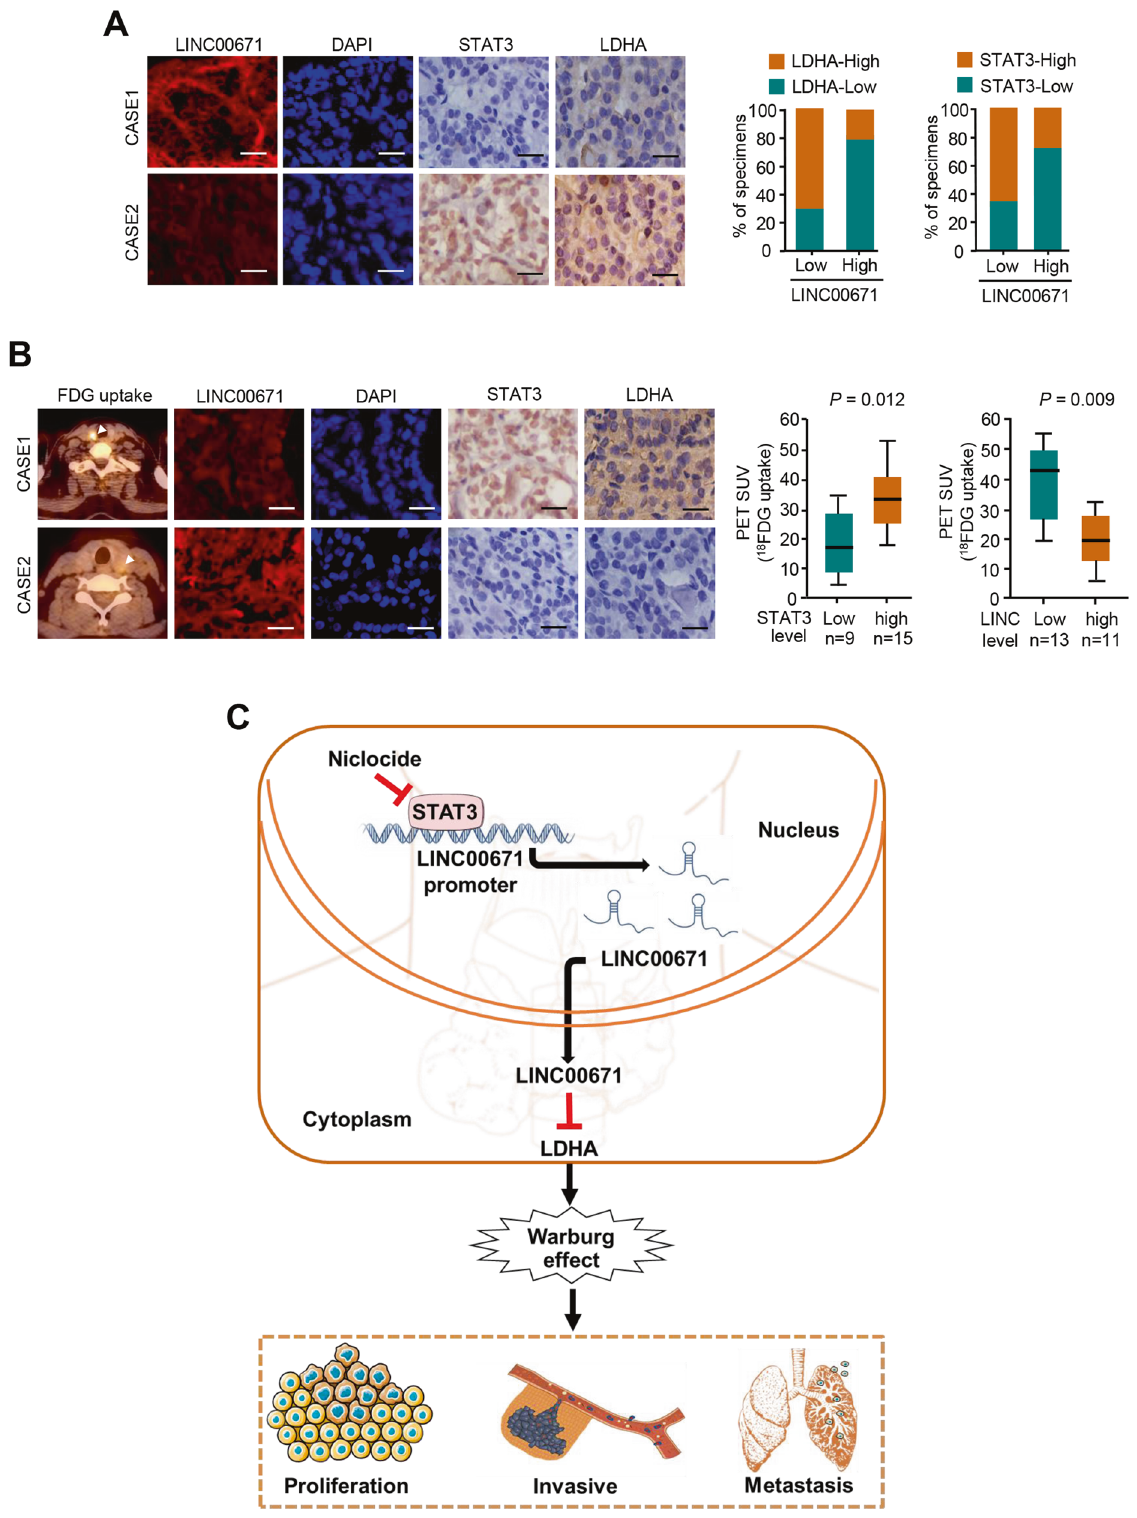
Fig. 7 Correlation between the expression of LINC00671 and LDHA and association of LINC00671 with glucose uptake in patients with thyroid cancer. A Representative IHC staining for STAT3, LDHA, and FISH staining for LINC00671 in PTC patients. Scale bar, 50 μ m. Right panel showing the percentage of specimens with low or high LDHA and STAT3 expressions in the low or high LINC00671 expression groups. CASE 1 and CASE 2 refer to two representative samples categorized by low and high LINC00671 expression. B The correlation of glucose uptake in thyroid cancer patients with different expressions of LDHA, STAT3, and LINC00671 using the Mann – Whitney U test. CASE 1 and CASE 2 refer to two representative samples categorized by low and high FDG uptake. Scale bar, 50 μ m. C Graphical abstract underlying the role of the STAT3/ LINC00671/LDHA axis in regulating PTC growth and lung metastasis.